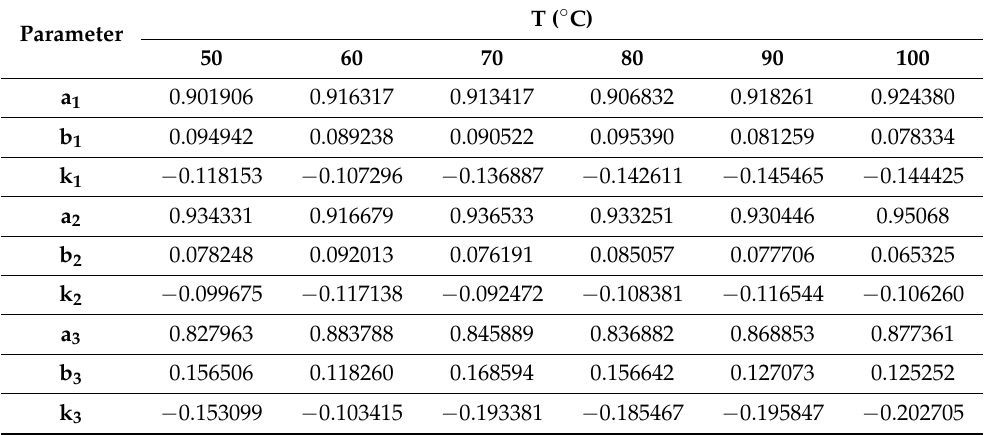
Table 2. Statistical parameters of Equations (1–3), obtained after fitting to experimental data of the volume and surface area of the ceramic block throughout